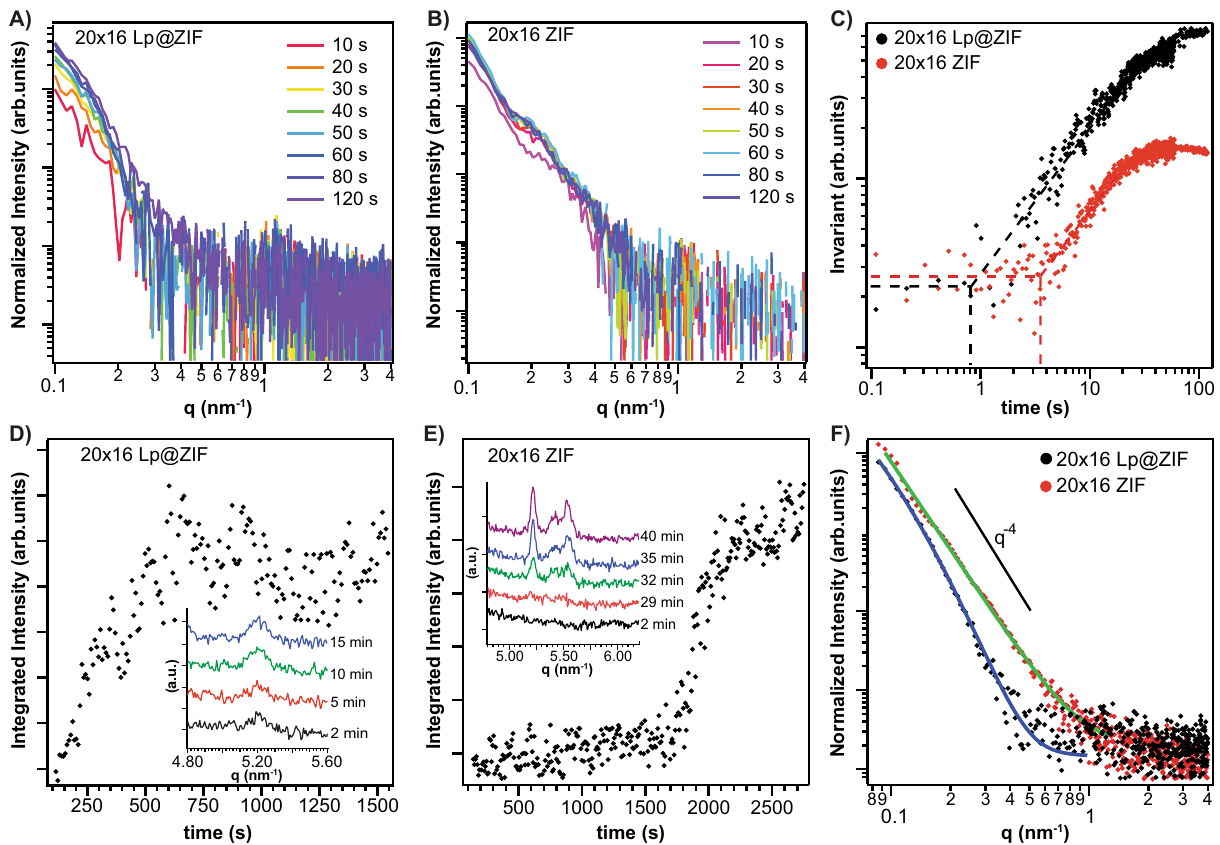
Fig. 3 X-Ray Diffraction Kinetics Study of Biomimetic ZIF Formation. Time evolution of SAXS patterns (background subtracted) from time ‐ resolved SAXS synthesis of ( A ) 20×16 Lp@ZIF. 10s (magenta), 20s (orange), 30s (yellow), 40s (green), 50s (blue), 60s (dark-blue), 80s (light-purple), and 120s (dark- purple). B 20×16 ZIF measured at 10s intervals. 10s (pink), 20s (magenta), 30s (dark-orange), 40s (light-orange), 50s (green), 60s (blue), 80s (dark- blue), and 120s (purple). C Time evolution of invariant Q ̃ calculated from 0.1 to 0.6nm − 1 of the time ‐ resolved SAXS patterns in ( A , B ) and corresponding to the synthesis of 20×16 Lp@ZIF (black dots) and 20×16 ZIF-L (red dots). The dashed lines are plotted to highlight the starting time of the Q ̃ increase. D Time evolution of the integrated intensity of (200) diffraction peak of ZIF-L (5.25nm − 1 ) calculated from time ‐ resolved SAXS synthesis 20×16 Lp@ZIF and ( E ) 20×16 ZIF-L. In the insets, selected diffraction patterns highlighting the time-evolution of the (200) diffraction peak of ZIF-L (5.25nm − 1 ) are reported. Color scheme for ( D ): 2min (black), 5min (red), 10min (green), and 15min (blue), and E: 2min (black), 29min (red), 32min (green), and 35min (blue), and 40min (purple). Time zero is referred to the end of the precursors mixing. F SAXS patterns (background subtracted and averaged) and fi tted data 120s after mixing the precursors of 20×16 Lp@ZIF (black dots) and 20×16 ZIF-L (red dots). The theoretical Porod power law ( I ( q ) / q − 4 ) is plotted for